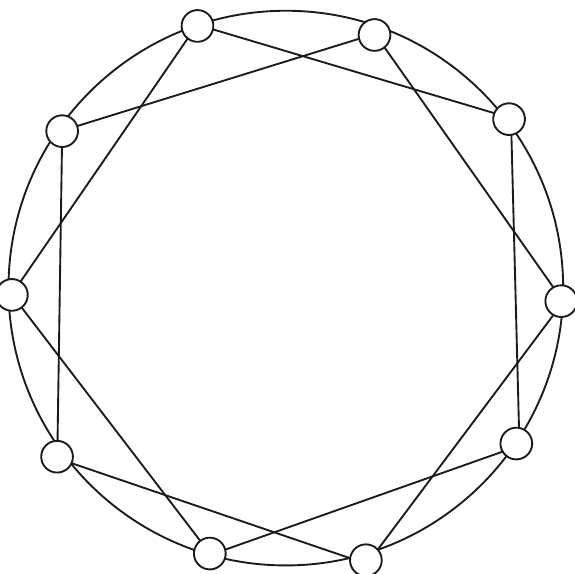
Figure 7: Nearest neighbor coupled